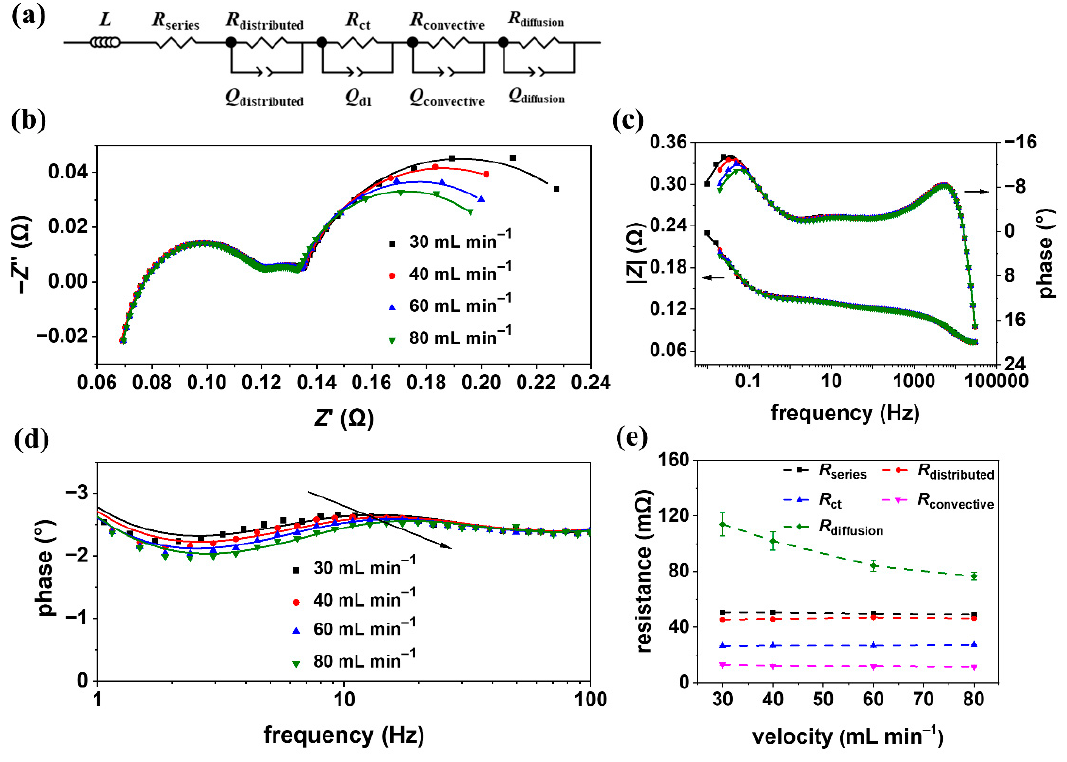
Figure 2. Full cell impedance recorded at OCV at various flow rates. ( a ) Equivalent circuit model of the impedance spectra; ( b ) Nyquist plots; ( c ) Bode plots; ( d ) Bode phase plots in 100–1 Hz; ( e ) Resistance value derived from the data fitting. The cell was assembled using 5 mm electrodes. The electrolyte concentration was 0.050 M K 3 [Fe(CN) 6 ] at 50% SOC. The symbols and the solid lines in Nyquist and Bode plots show the experimental and the fitted data,